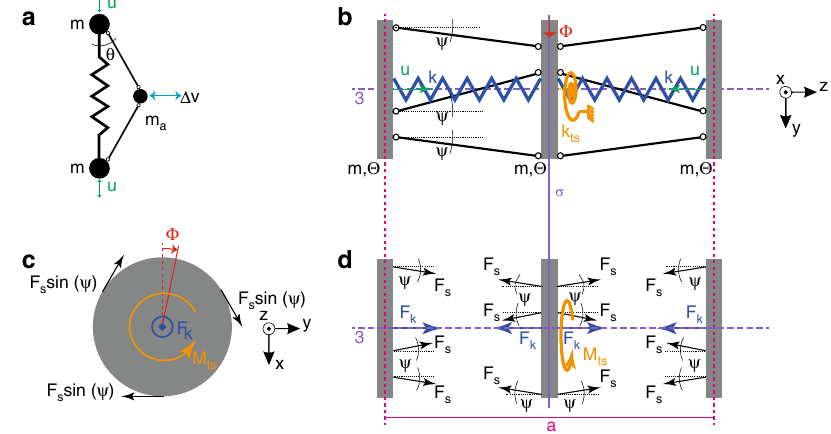
Fig. 3 Coupling mechanism. a Inertial ampli fi cation mechanism initially proposed in 23 , where the range of motion Δ v of m a is a multiple of the range of motion u of m : Δ v = u /tan θ , due to the kinematic constraint imposed by the stiff levers. b Example of a phononic crystal with coupled longitudinal rotational degrees of freedom, in which to a displacement u of the outer atoms corresponds a rotation Φ of the middle atom. This coupling is enforced by the excentric diagonal struts. The elastic elements, a longitudinal and a torsional spring, with the stiffness k and k ts , respectively, provide the restoring force and moment respectively to return the atoms to the equilibrium position. c, d Forces and moments acting on the atoms at controls the ratio between the longitudinal and rotational motion ( u and Φ ), and the ratio of moment of inertia Θ and mass m , that can be exploited to tailor the propagation of mechanical waves. Similarly, also the symmetry operations with respect to the atoms of the unit cell represent an additional tailoring property.